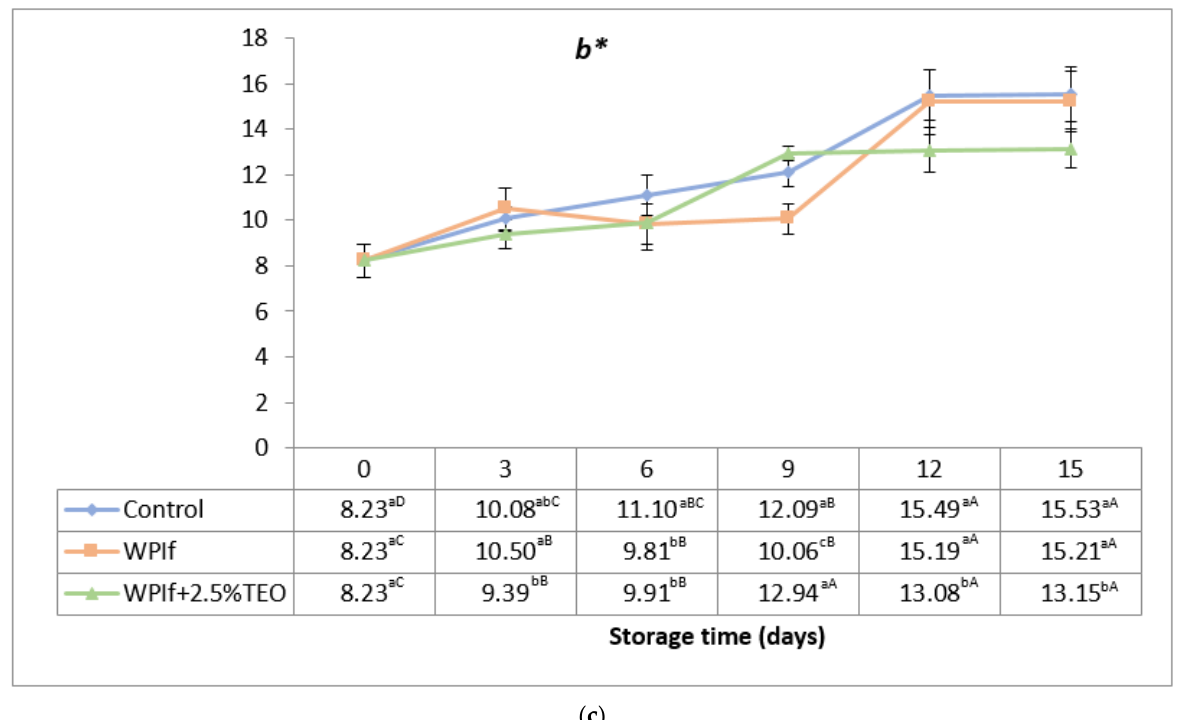
Figure 5. Changes in color attributes of brook trout samples during refrigerated storage. ( a ) L* ; ( b ) a* ; ( c ) b* . Control-uncovered fish samples; WPIf-fish samples covered with WPI-based films; WPIf+2.5%TEO-fish samples covered with whey protein isolate-based films incorporated with 2.5% tarragon essential oil. Values are expressed as mean ± standard deviation of twelve replicates. Means that do not share a letter (lowercase letters on column and uppercase letters on row) are significantly different.